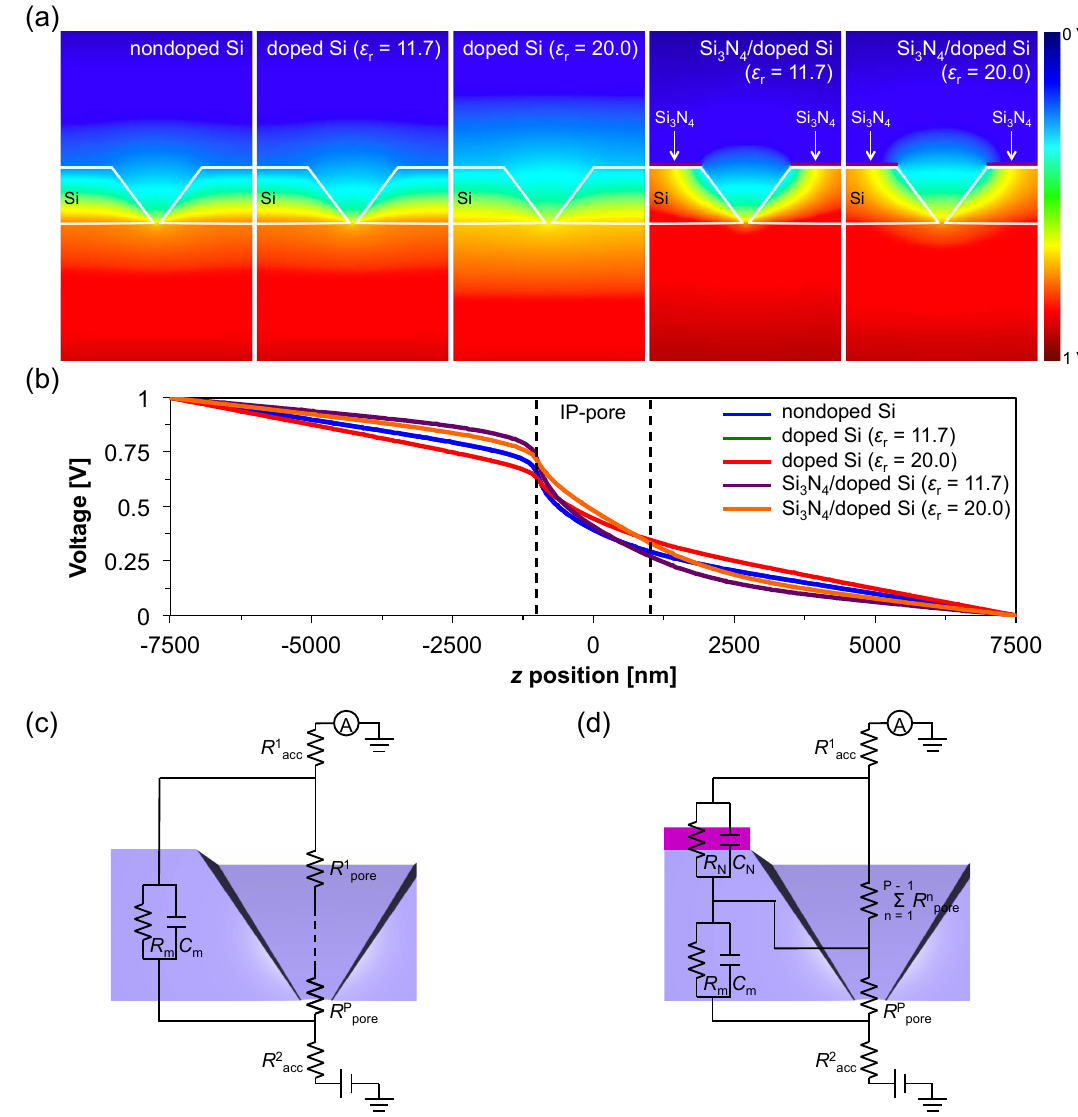
Figure 3. Simulation results for the IP-shaped nanopore structures. ( a ) Cross-sectional potential distributions for the nondoped Si, the doped Si, and the Si 3 N 4 / doped Si nanopores. The potential drop was found to depend on the structure and the material permittivity. ( b ) Potential dependencies on the z position on the center axis ( x = 0, y = 0) for the nondoped Si (blue), the doped Si ( ε r = 11.7) (green), the doped Si ( ε r = 20) (red), the Si 3 N 4 / doped Si ( ε r = 11.7) (purple), and the Si 3 N 4 / doped Si ( ε r = 20) (orange) nanopores. Here, as the dependences of the nondoped Si and the doped Si ( ε r = 11.7) are almost the same property, the potential curves are overlapped. ( c ) Equivalent circuit of the Si-based IP-shaped nanopore. ( d ) Equivalent circuit of the Si 3 N 4 / Si-based IP-shaped